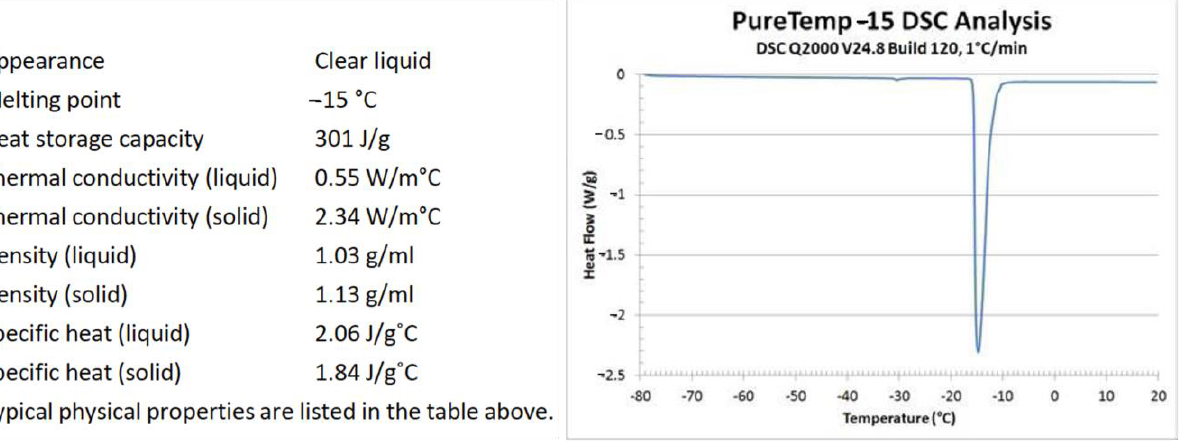
Figure 1. Physical properties of PCMs (PureTemp LLC.) .